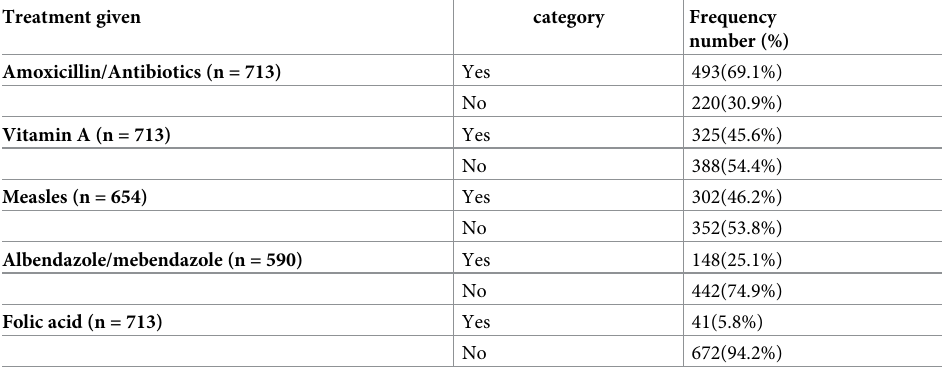
Table 3. Treatments given information to children with SAM enrolled to OTP in Dire Dawa, Ethiopia; from Janu- ary, 2013 to December, 2016. Treatment